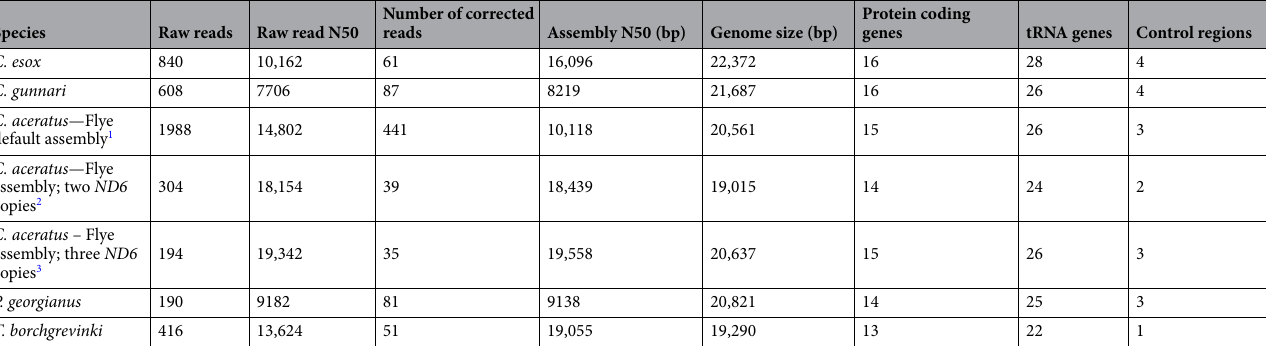
Table 1. Raw and canu-corrected read statistics, genome size and content of mt genomes of species in this study. 1. The default C. aceratus mt genome assembly generated from all reads. 2, 3. C. aceratus mt assemblies generated by reads containing 2 and 3 ND6 copies respectively (as determined by k-mer